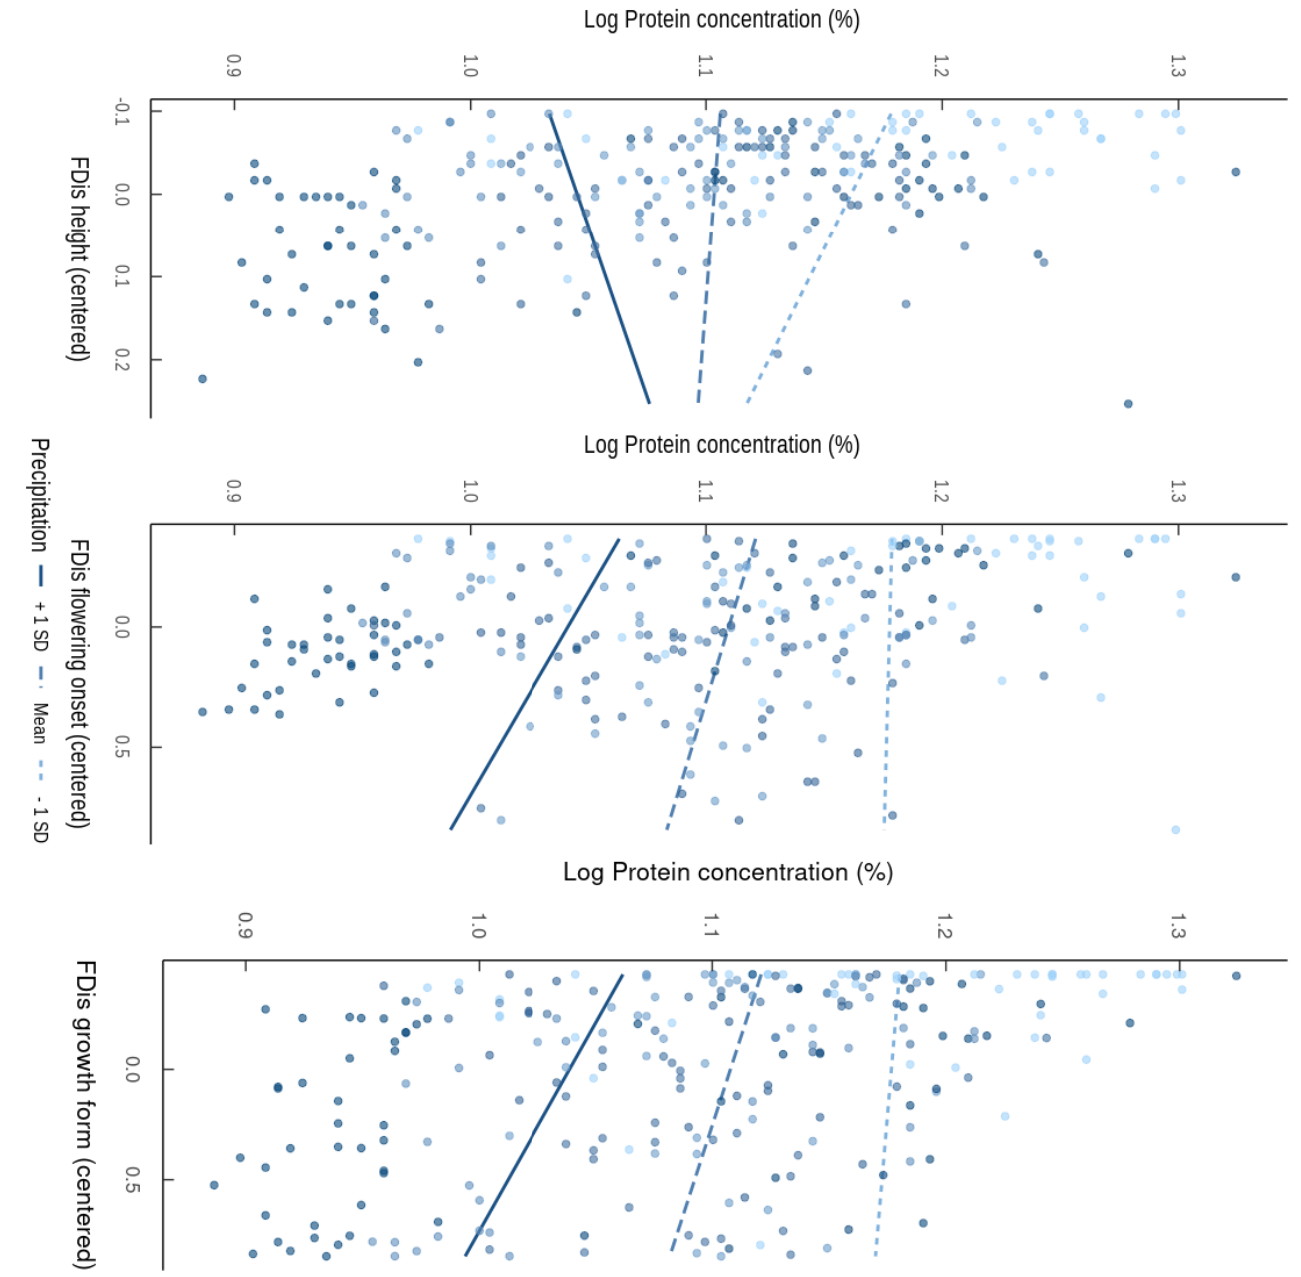
Figure 1. Interaction between FDis height, FDis flowering onset and FDis growth form of weed communities and precipitation during the crop season to explain protein concentration in wheat grains. FDis indices and precipitation were centered before the analysis. Lines show the effect of FDis measures on protein concentration when precipitation takes the mean value and values one standard deviation higher or lower than the mean. Observed data points are shaded in blue depending on the precipitation value registered on the